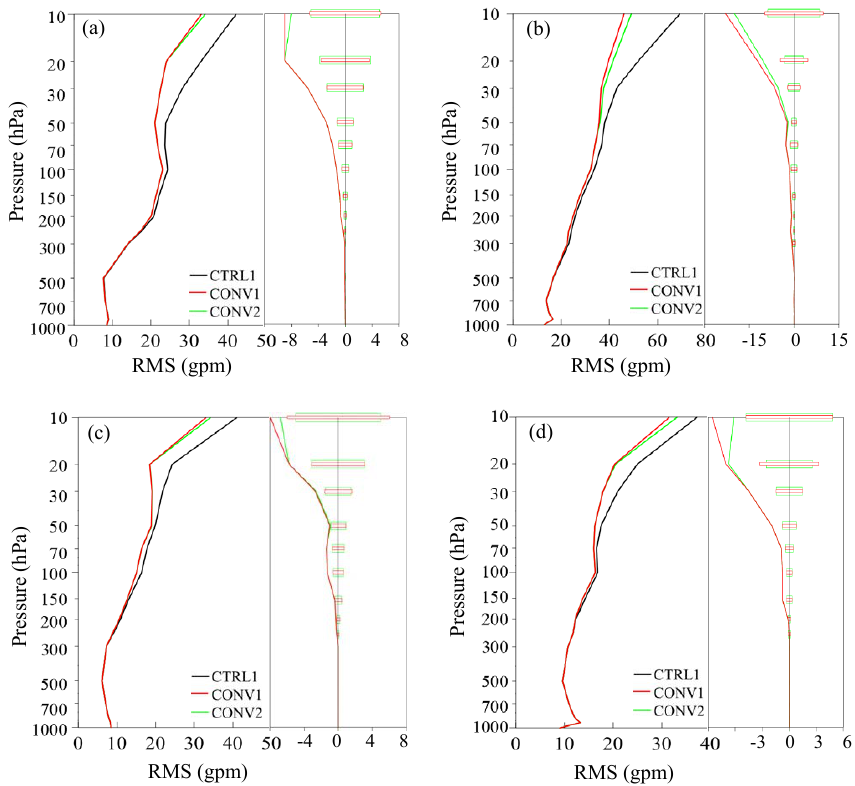
Figure 12. RMS of geopotential height from the analysis field difference between CTRL1 and NCEP (black), CONV1 and NCEP (red), CONV2 and NCEP (green) in the (a) Northern Hemisphere, (b) Southern Hemisphere, (c) the tropics, and (d) East Asia during 1– 27 July 2014. The statistical significance testing of CONV1 and CTRL1 (CONV2 and CTRL1) are shown in the right part of each figure in red (green). The RMS differences outside of outline bars are significant at the 95% confidence